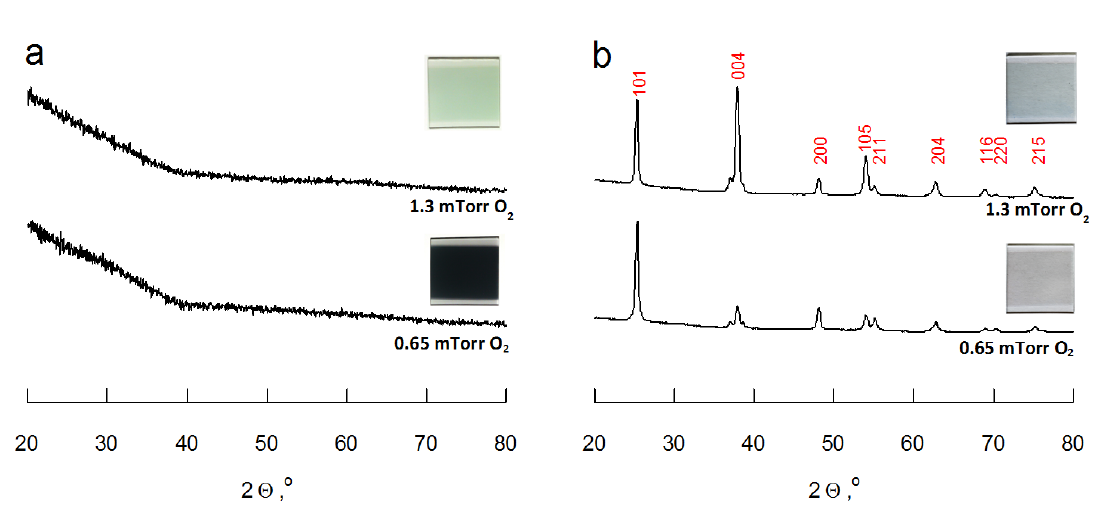
Figure 1. XRD diffractograms of post-annealed ( a ) non-oriented and ( b ) <001> oriented films (the intensity ordinates for the two samples are shifted and given in arbitrary